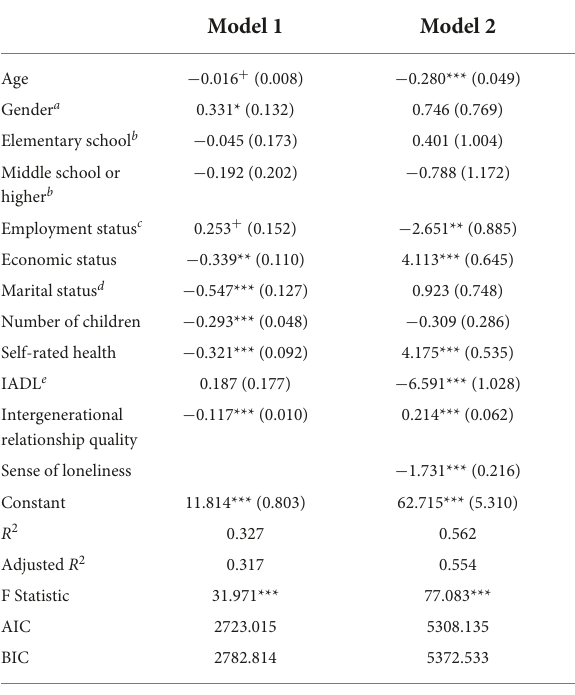
TABLE 3 Results of multiple linear regression predicting loneliness and attitude toward later